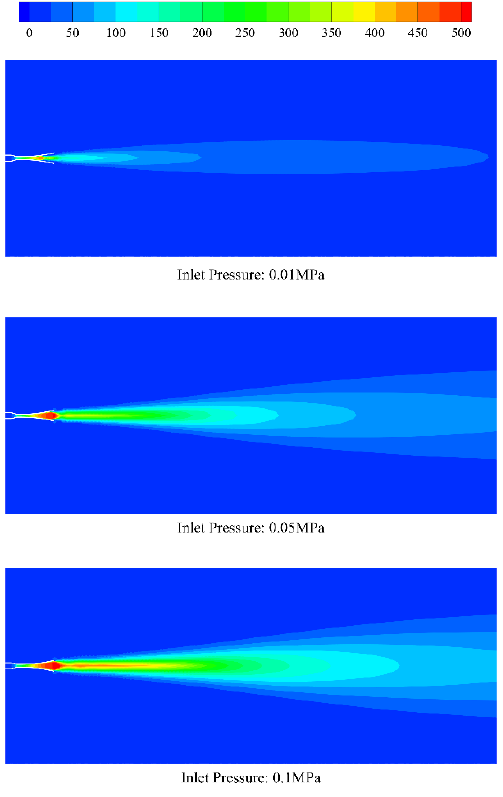
Figure 4. Velocity contours of nozzle #3 at different inlet pressures (m/s).